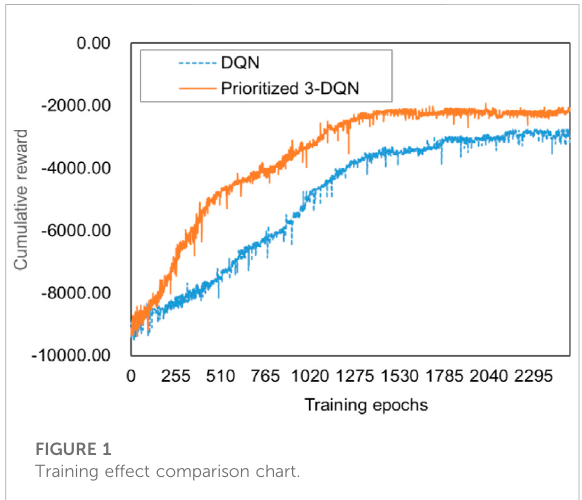
TABLE 5 Algorithm parameter setting.